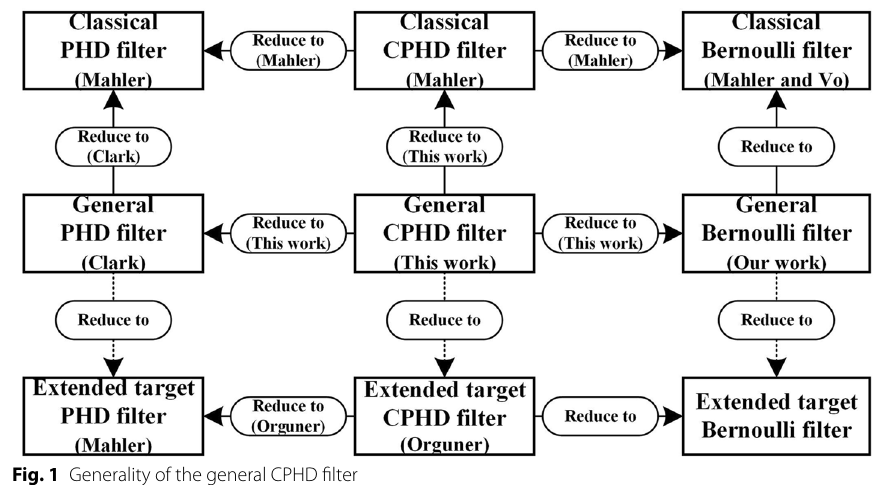
Fig. 1 Generality of the general CPHD